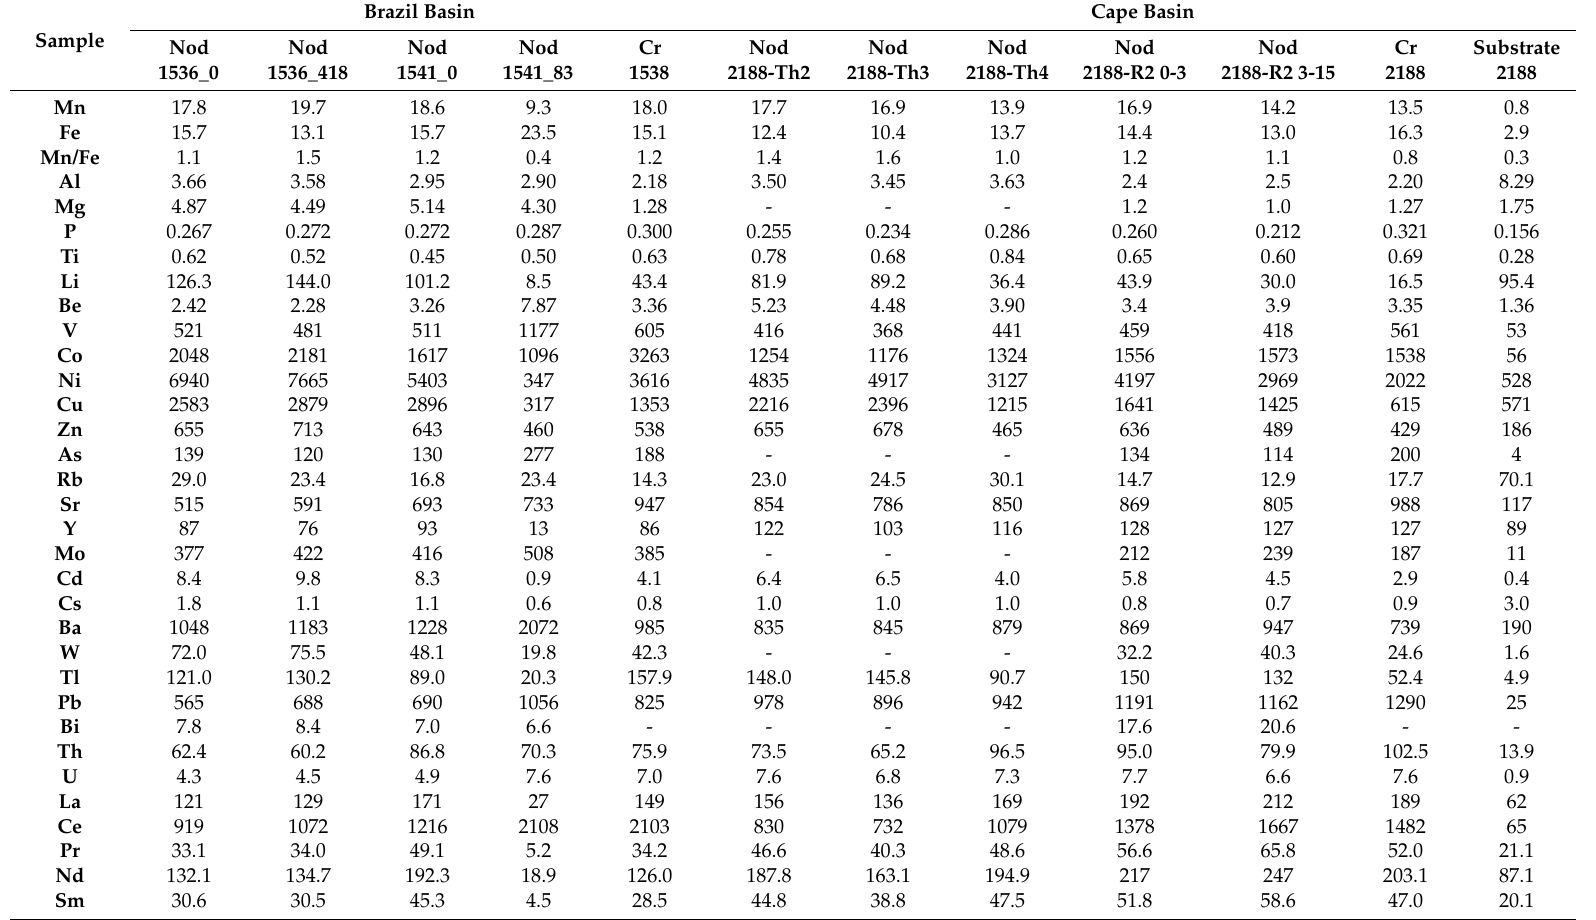
Table 3. Concentrations of major and trace elements of crust and nodules from the Cape and Brazil